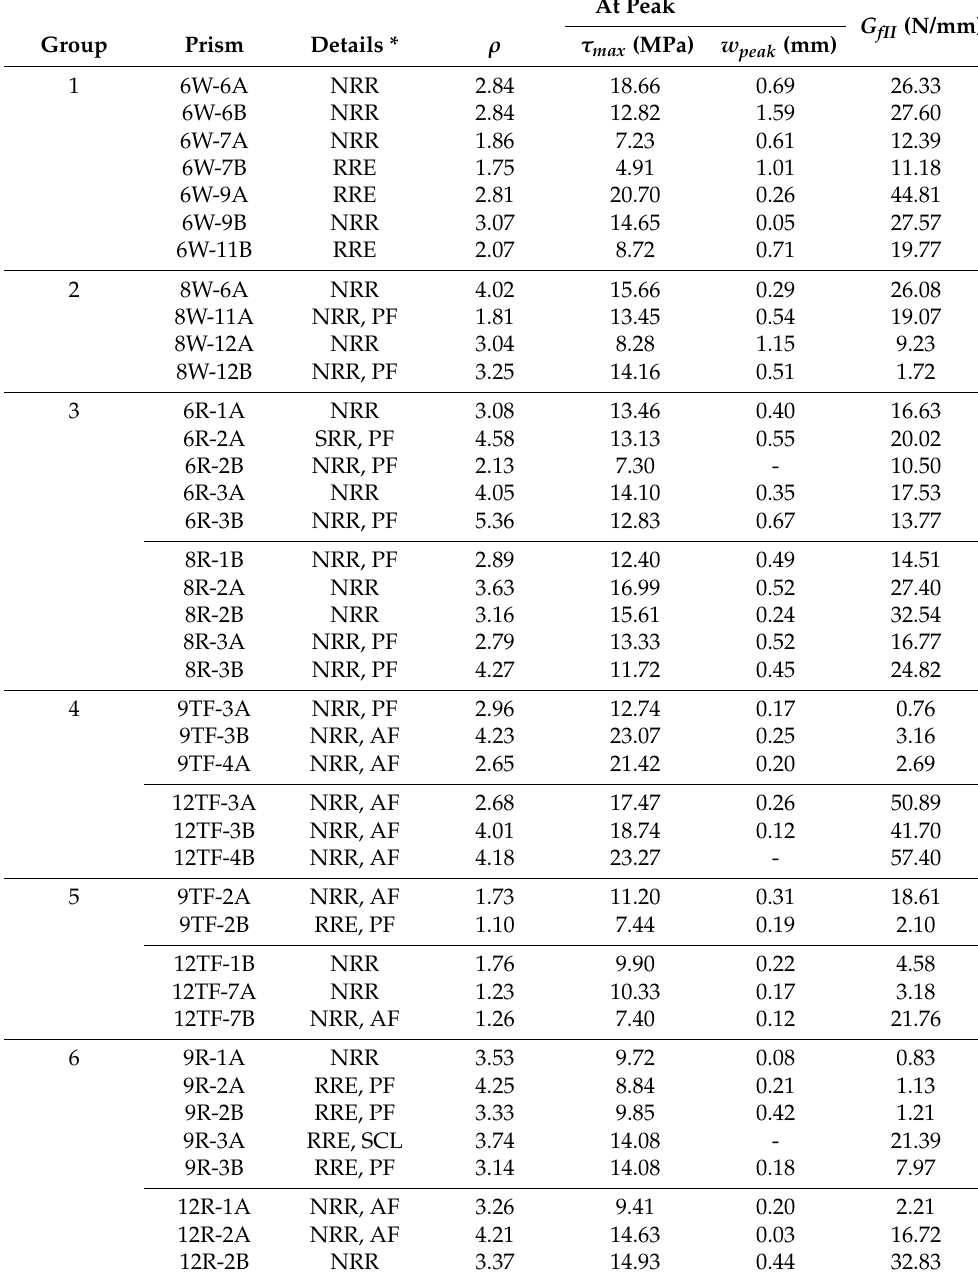
Table 3. Results of shear